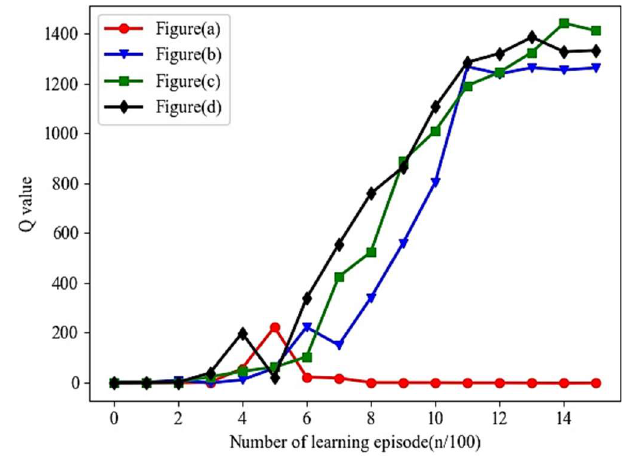
Figure 8. Q-value curve.